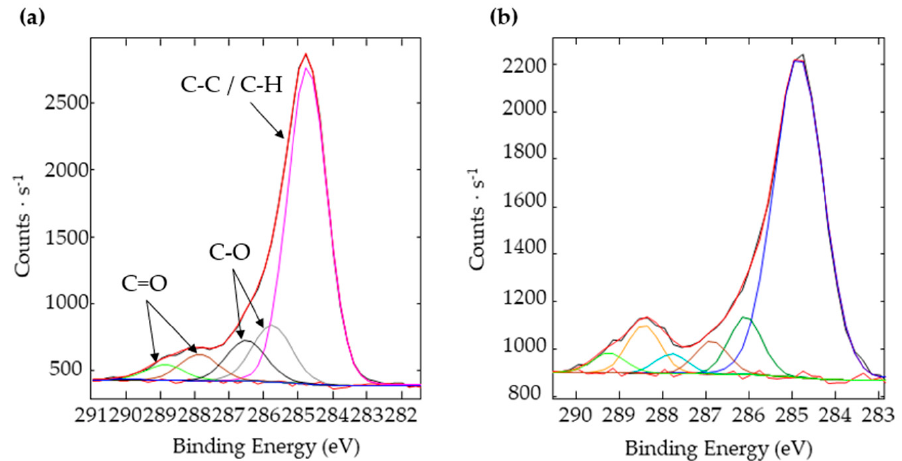
Figure 18. Deconvolution of the C1s spectra of the samples with no square pillars’ top irradiation textured under a CO 2 flow for which wetting evolution measurements were ( a ) carried out and ( b ) not carried out.